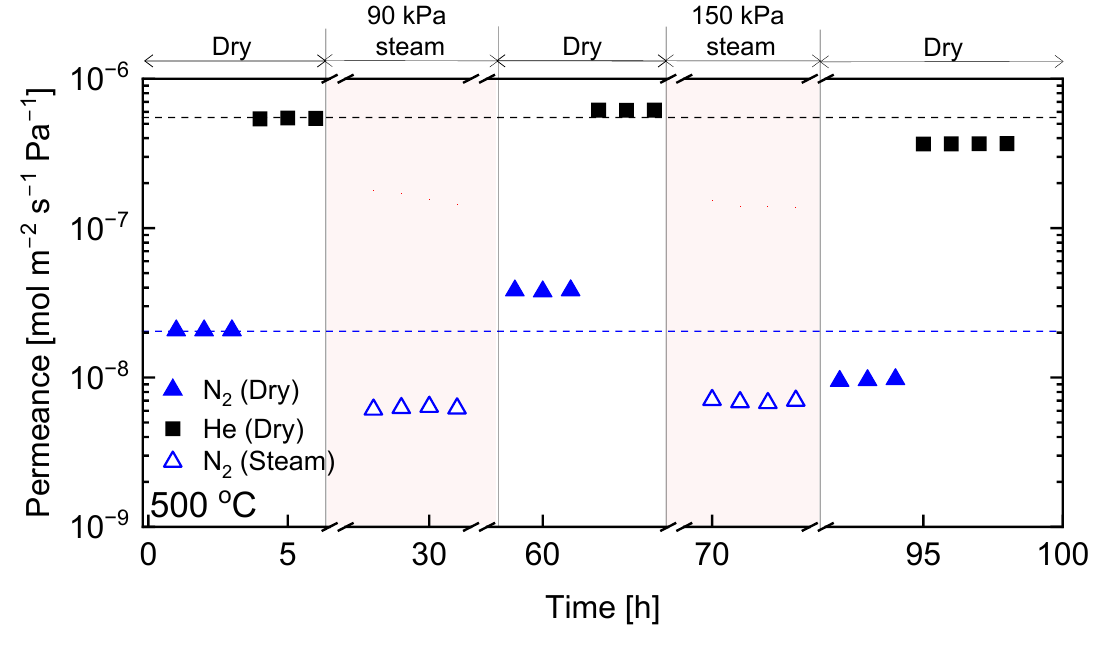
Figure 9. Time courses of hydrothermal stability tests at 500 °C in a mixture of H 2 O+N 2 (90 and 150 kPa of steam partial pressure; total pressure of 300 kPa) for carbon-SiO 2 -ZrO 2 membranes prepared at 550 °C.